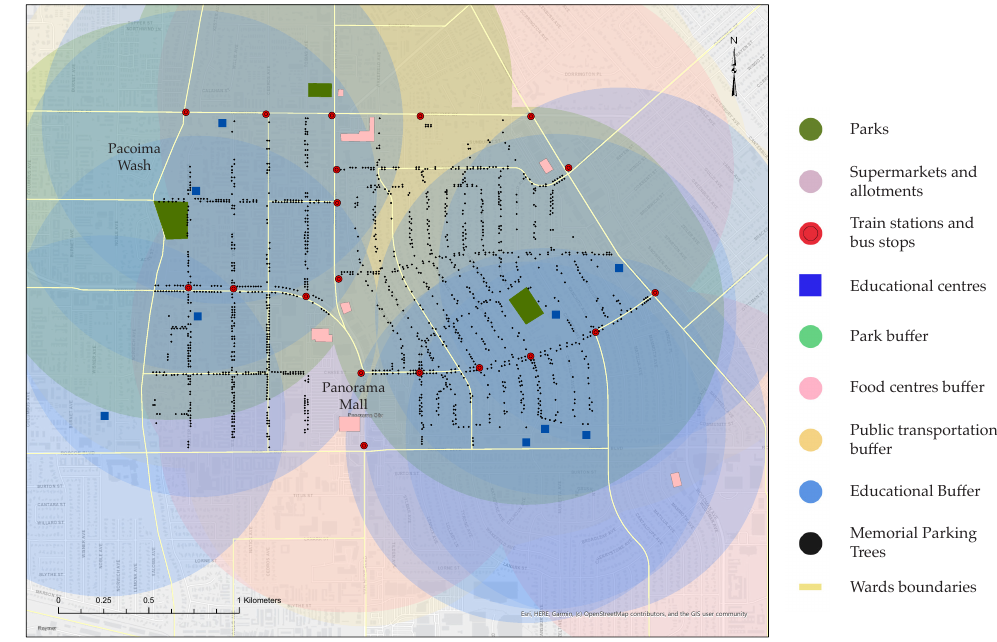
Figure 11. A total of 1501 spaces were found in this designed suburban